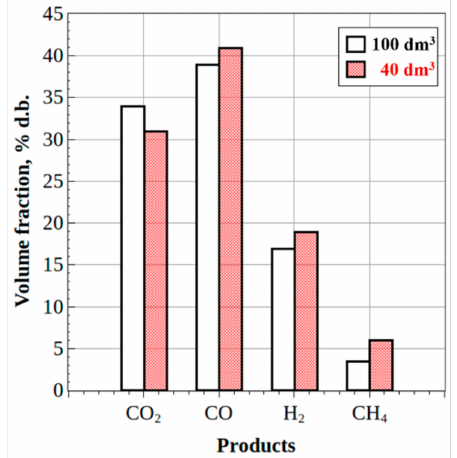
Figure 9. Measured steady-state compositions of cooled dry syngas obtained by gasification of wood sawdust at f = 1 Hz and P ≈ 0.1 MPa in 100- and 40-dm 3